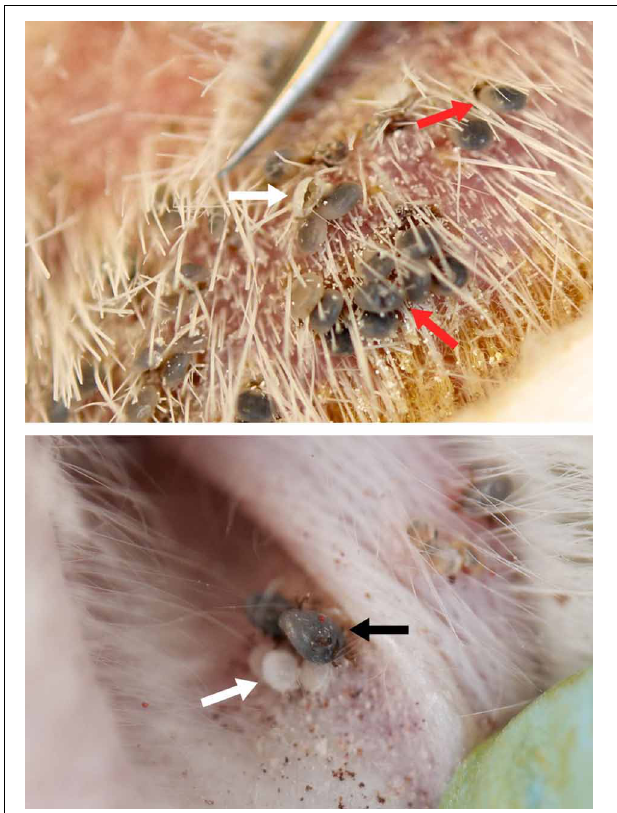
FIGURE 3 | Molting larvae and newly emerged nymphs feeding on guinea pig (top) and rabbit (bottom). Red arrows indicate molting larvae. White arrows show ruptured cuticles left from molted and emerged larvae still attached to the skin. Newly emerged nymphs feeding in close proximity to where they fed as larvae (black